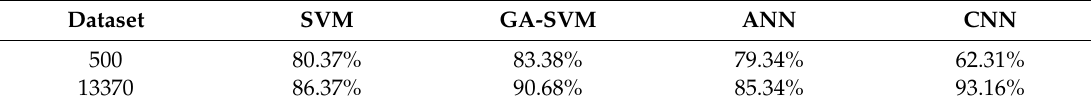
Table 5. Comparison of prediction accuracy with four models for two di ff erent datasets.